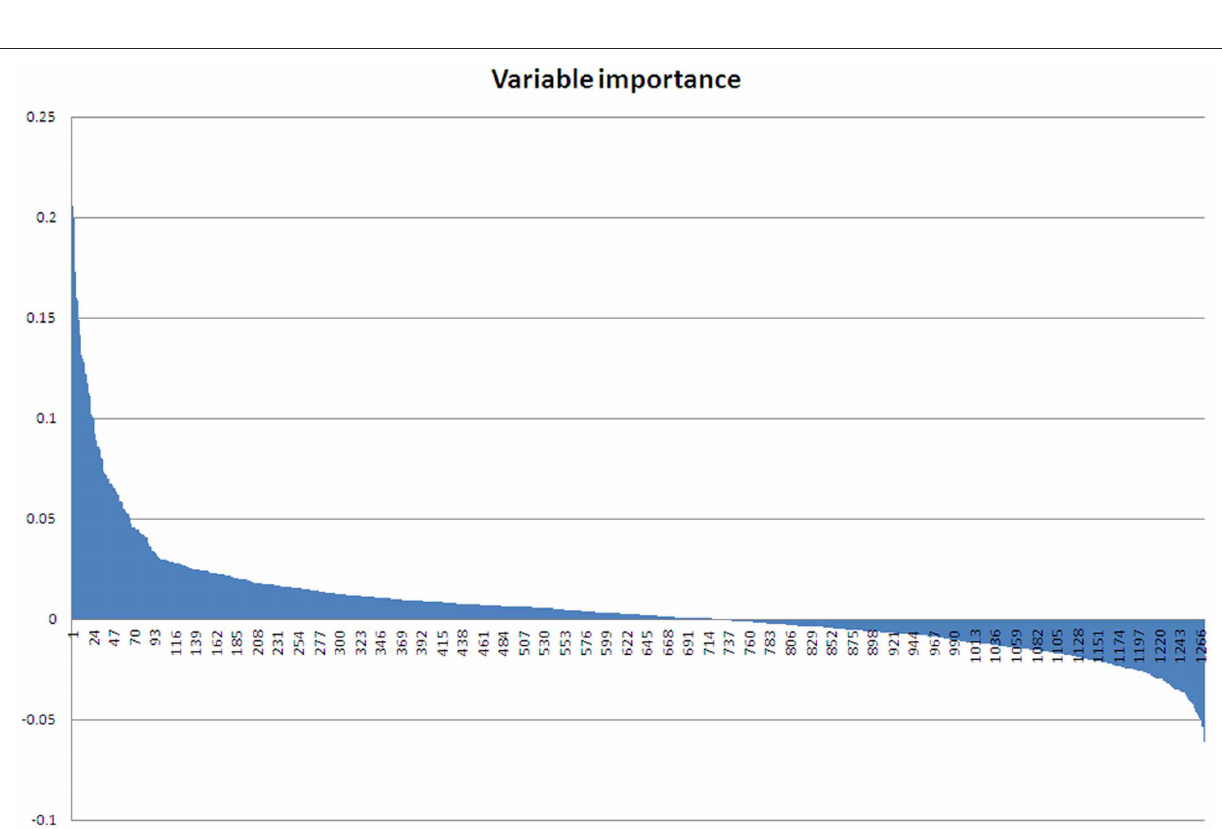
FIGURE 4 | Variable importance plot. Variables with a positive loading score for PC1 have a high abundance in stressed samples, variables with a negative loading score for PC1 have a high abundance in control samples.